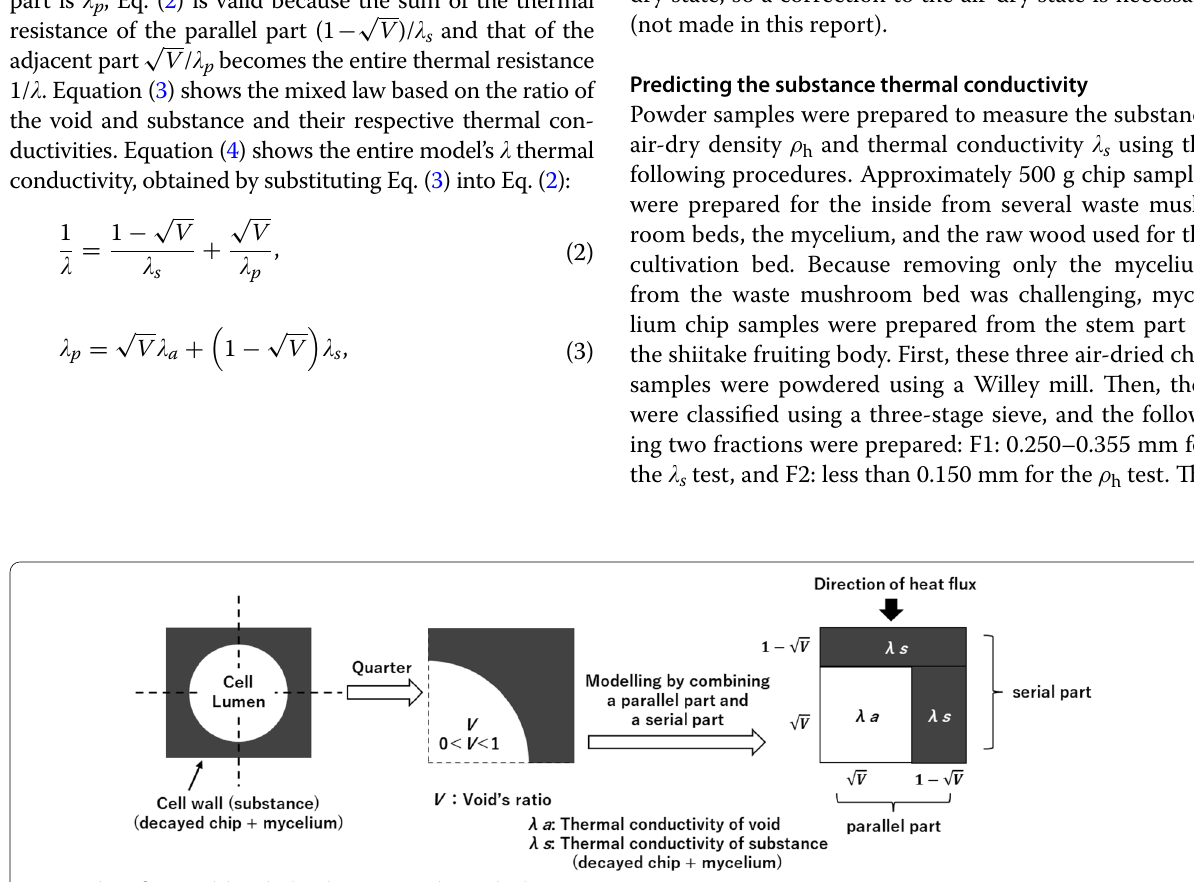
Fig. 5 A heat-flow model applied to the waste mushroom